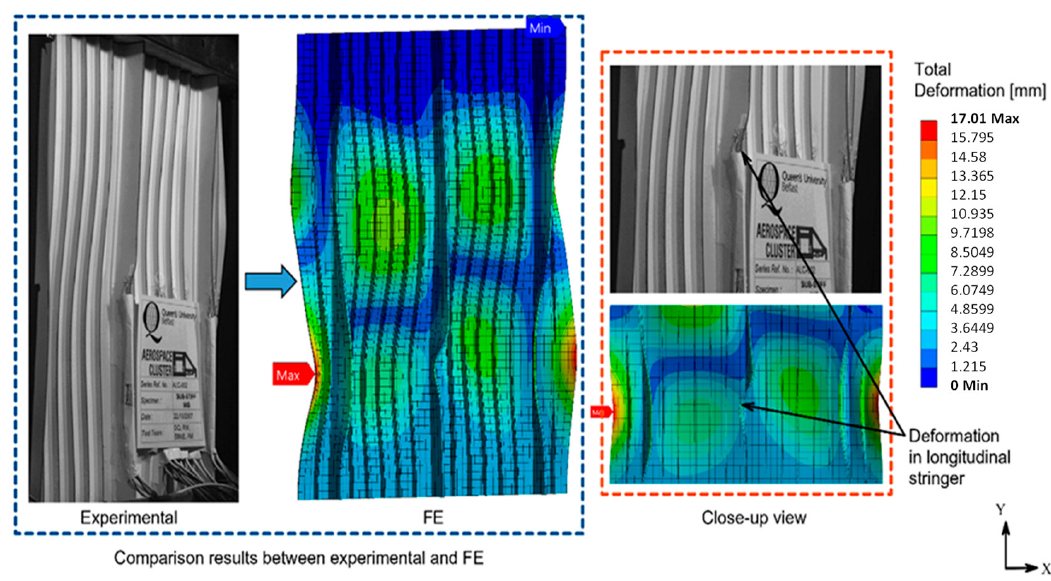
Figure 8. Result comparison between experimental data [41] and FE on Specimen B.